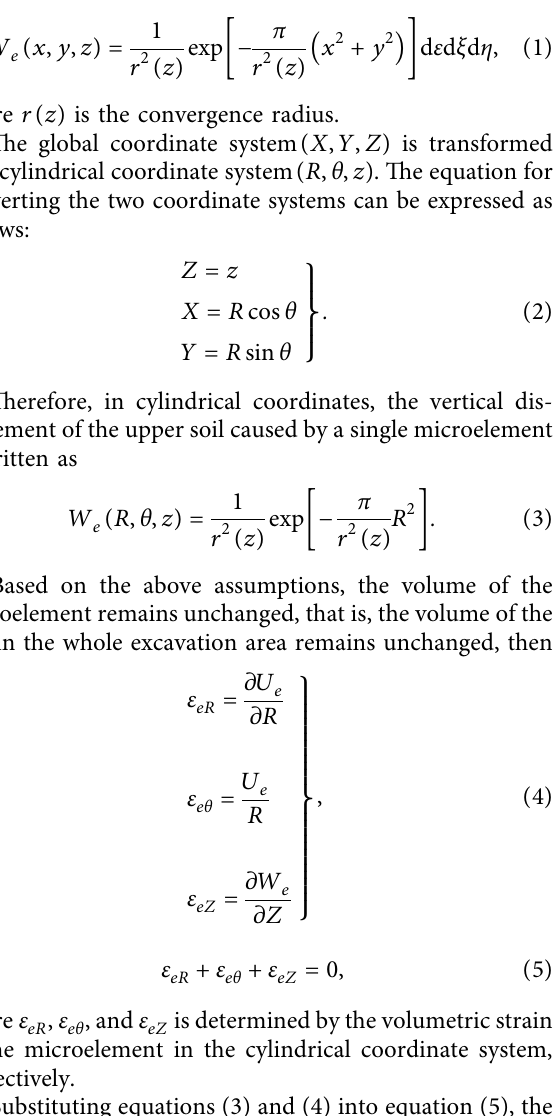
Figure 1: Unit volume